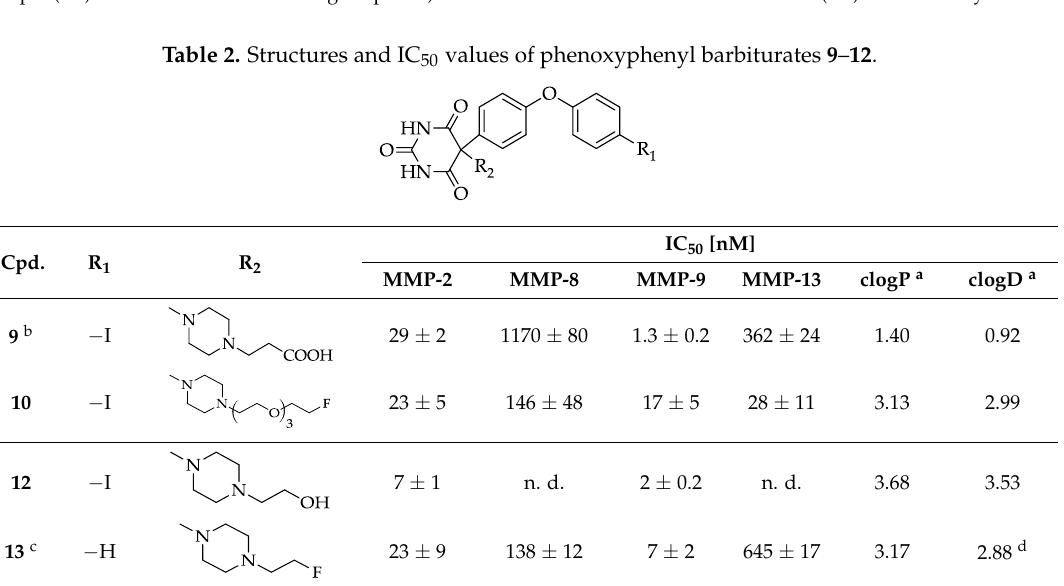
Cpd. Cpd. Cpd. Cpd.